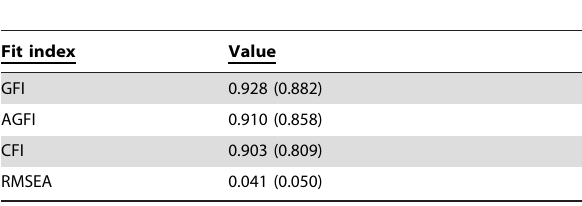
Table 6. Fit indices for confirmatory factor analysis of the SINS-CN scale (values prior to restriction imposed on the model are shown in